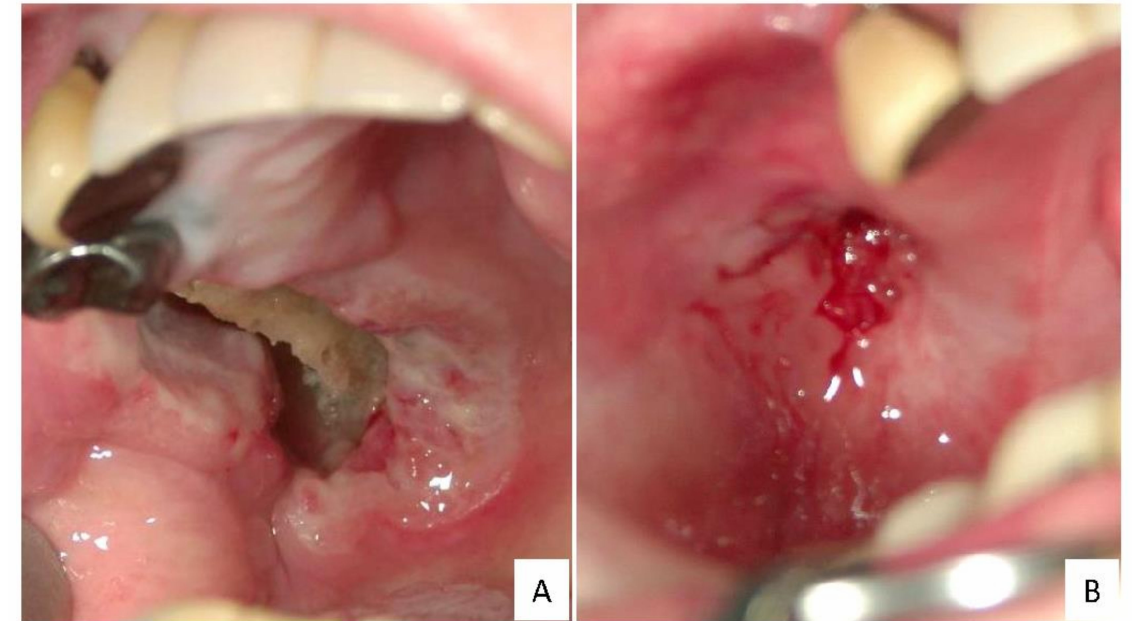
Figure 1. Representative macroscopic findings for EBVMCU in the gingival mucosa. The ulcer developed while the patient was on methotrexate ( A ). After the methotrexate dose was discontinued, the lesion spontaneously disappeared ( B ).